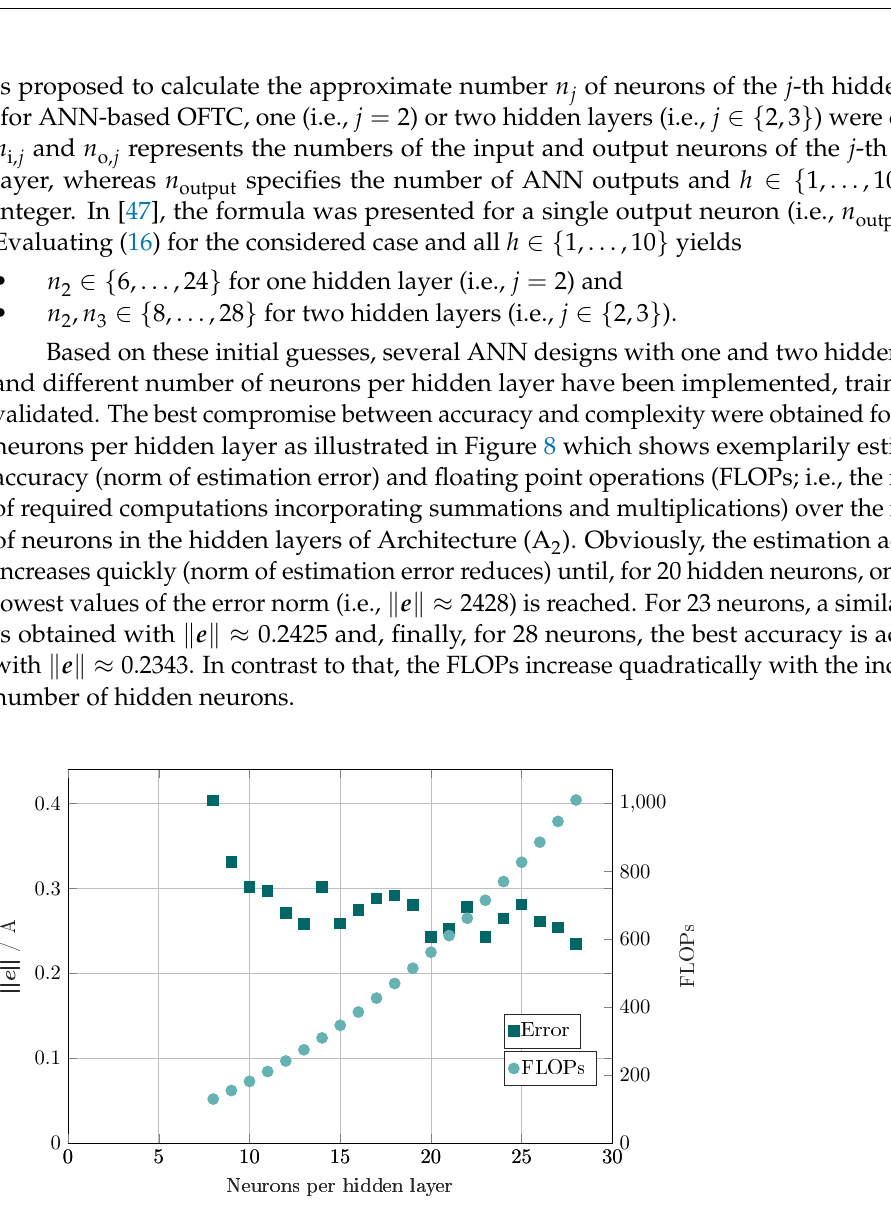
Figure 8. Illustration of estimation accuracy (norm of estimation error) and floating point operations of ANN Architecture (A 2 ) for different numbers of hidden layer